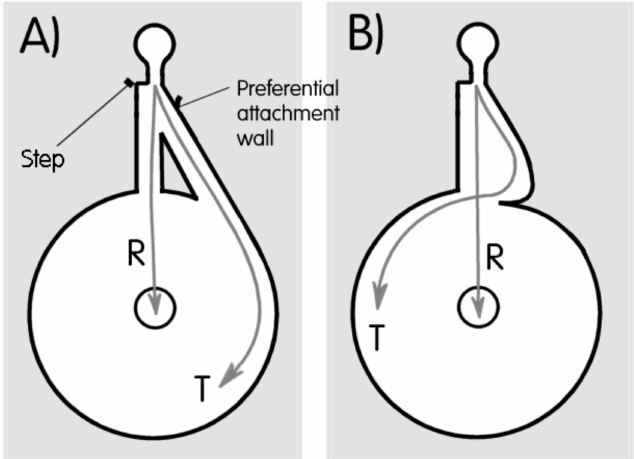
Figure 9. Two alternative geometries of a load-switched oscillator with single vortex chamber and monostable diverter. Radial inflow R leaves the chamber without rotation generated by the tangential inflow T. Direct tangent entry (A) may exhibit lower energy loss while (B) without the ”island” inside the pre-chamber is easier to manufacture by etching the cavities on a thin